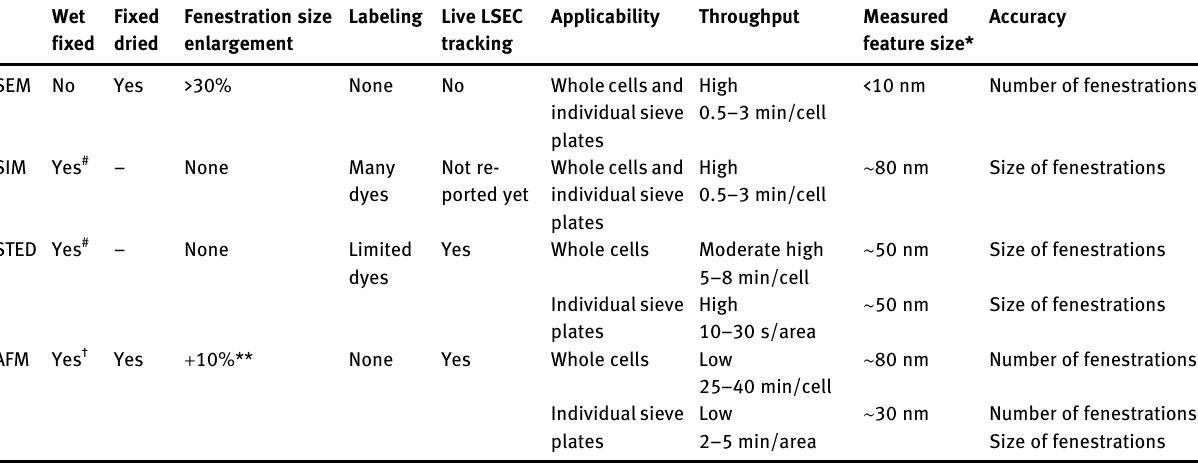
Table  : Summary of presented